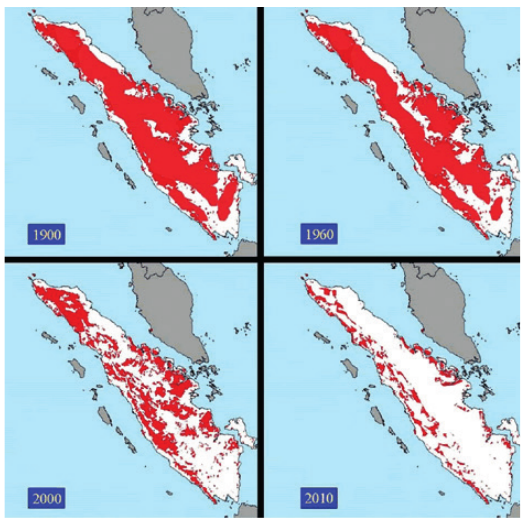
Figure 1. Forest loss on Sumatra due to logging and conversion to agriculture. The red depicts remaining forest